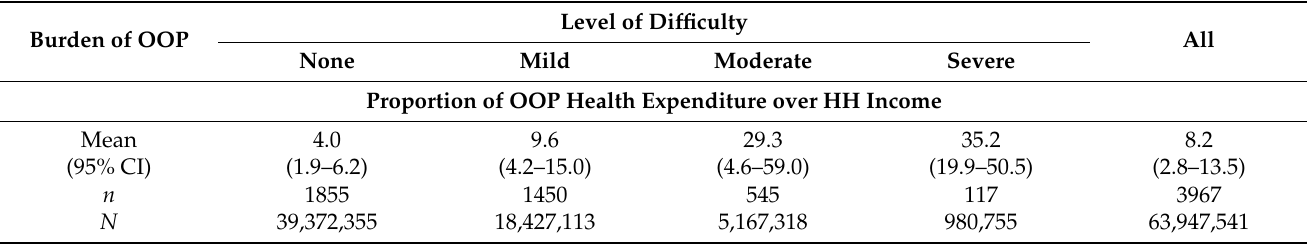
Table 4. Burden of OOP health